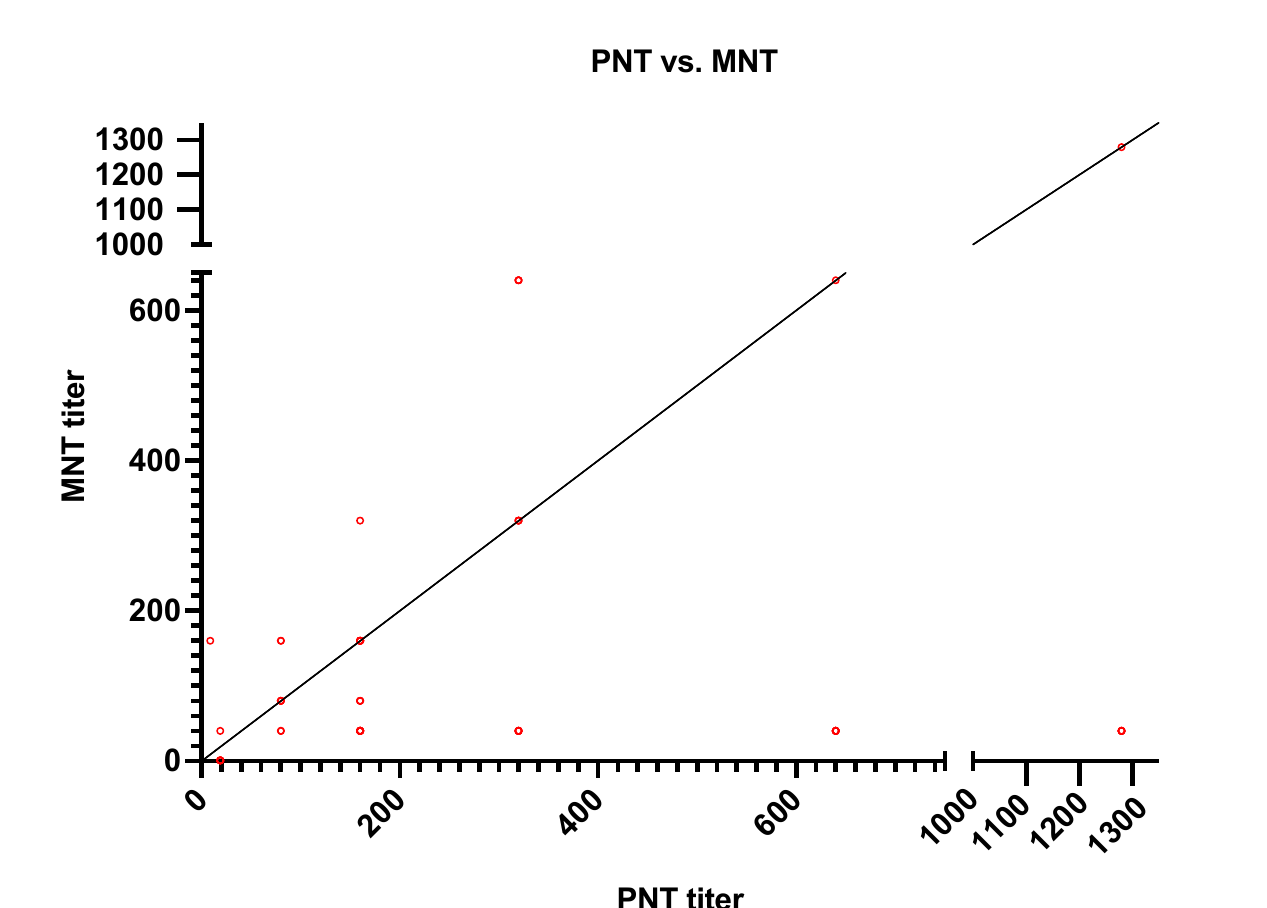
Figure 3. Correlation of SARS-CoV-2 Ab titers as detected by PNT ( x -axis) vs. MNT ( y -axis). Results show the concordance of antibody titers between MNT and PNT in 16 samples as follows: 4 samples had a titer of 1:80, 7 samples with a titer of 1:160, 3 with a titer of 1:320, and 1 each with a titer of 1:640 and 1:1280. PNT was constantly showing at least